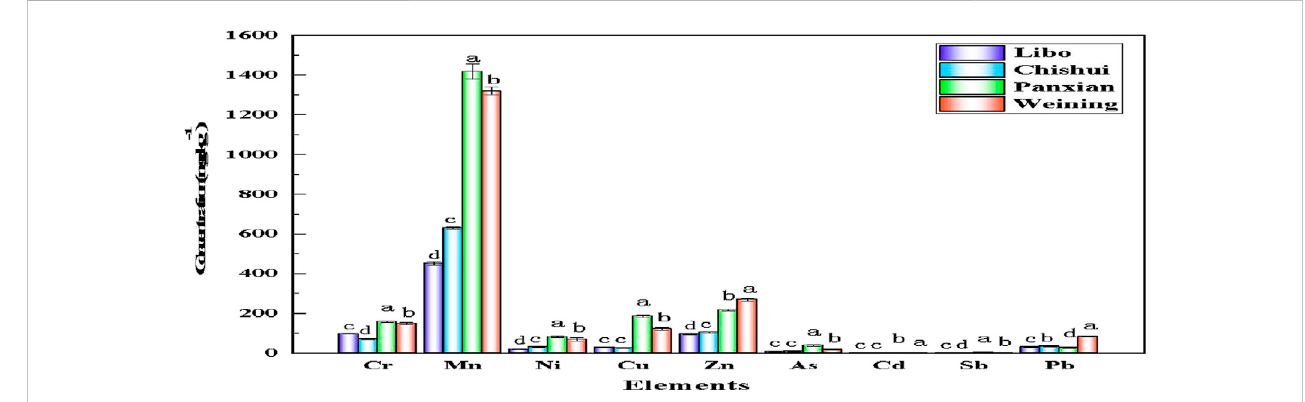
from Cd. A comparison of their fi ndings with those of this study indicates that the levels of Cu, As, and Cd are increasing over time. Morteza et al. (2019) evaluated the amount of heavy metal contamination in soil in the Persian Gulf (southern Iran), and the EF and I geo values indicated that the sediments were